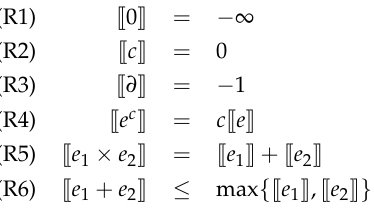
Figure 25. Syntax: E is a system of one or several equations e = e . An expression e is 0, a nonzero (standard) real constant c , the infinitesimal ∂ , a variable x , the monomial e c , a sum, or a product.